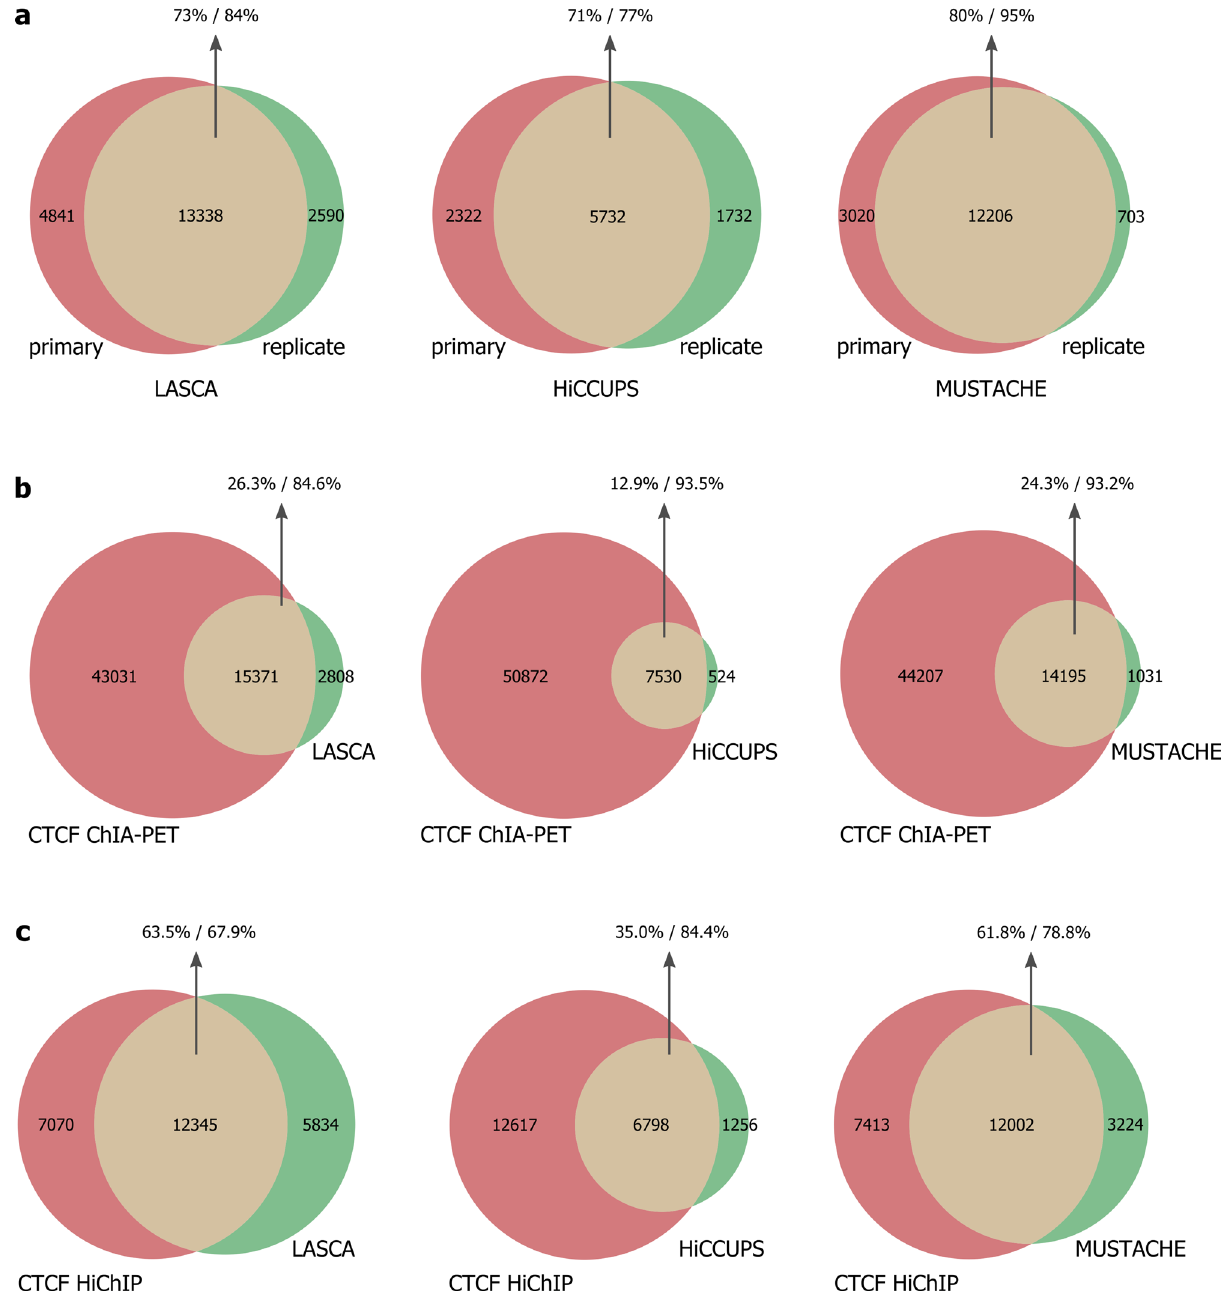
Figure 3. Reproducibility and accuracy of LASCA pipeline. ( a ) The overlap between loops identified by either LASCA, MUSTACHE or HiCCUPS in two Hi-C replicates of GM12878 cell line. ( b–c ) The overlap between either LASCA, MUSTACHE or HiCCUPS loops in GM12878 cells and loops detected by CTCF ChIA-PET ( b ) or by CTCF HiChIP ( c ). The overlap between the two loop sets is shown in yellow, and the percentages of overlap with respect to each set are reported